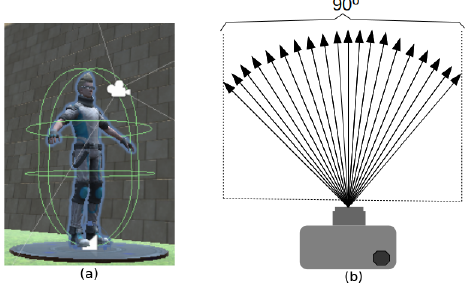
Figure 6. (a) Agent’s physical body and (b) ray casting with an aperture angle of 90 degrees and symmetrical perspective projection. A3C algorithm. Therefore, our network has an output array for the policy π ( s, g ; θ ) and an output value for the function V π ( s, g ; θ )